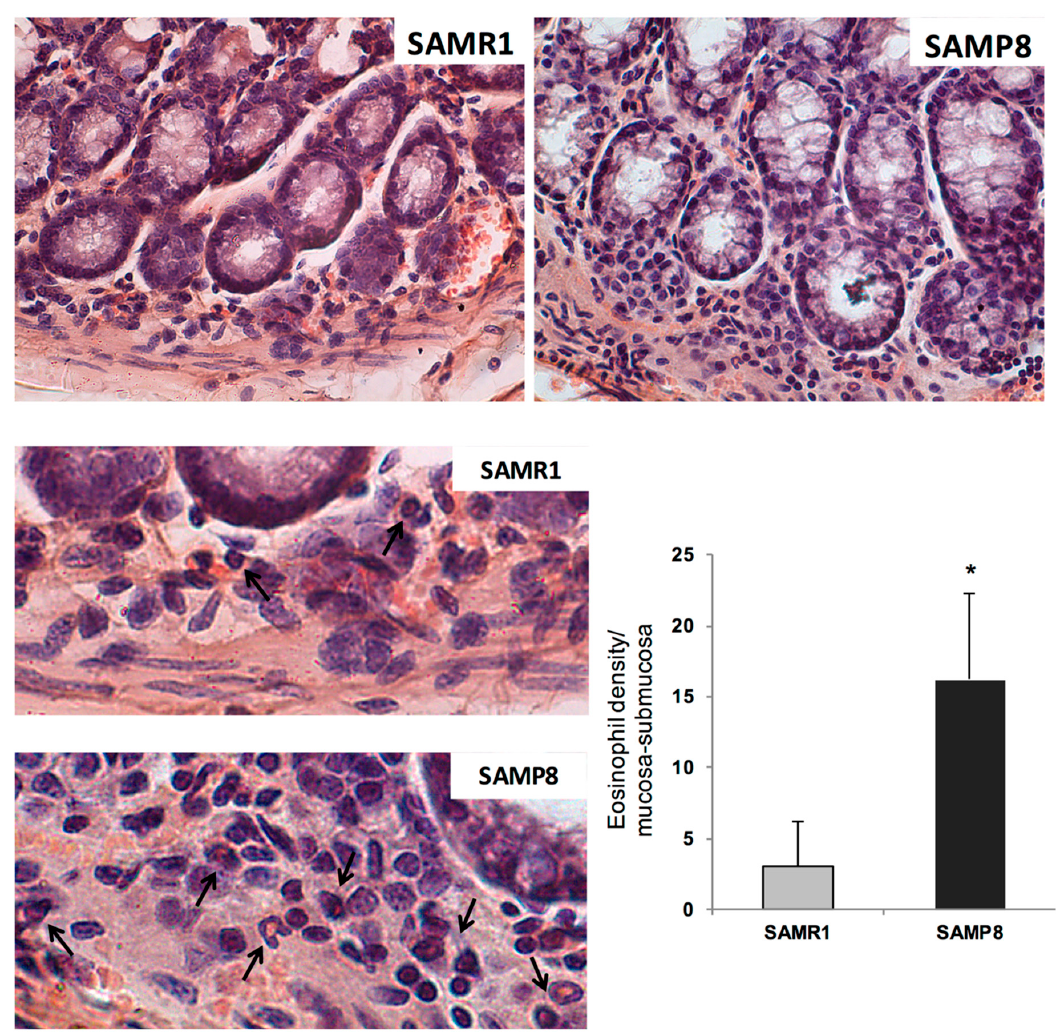
Figure 5. Representative pictures of Congo Red-stained eosinophils (black arrows) in colonic sections from SAMR1 and SAMP8 at six months of age. Original magnification: 40 × . The column graph displays the mean values of eosinophil density per square millimetre of tunica mucosa / submucosa areas (cells / mm 2 ) ± S.E.M. from eight animals. * p < 0.05. Statistics: Student’s t -test (for unpaired data).